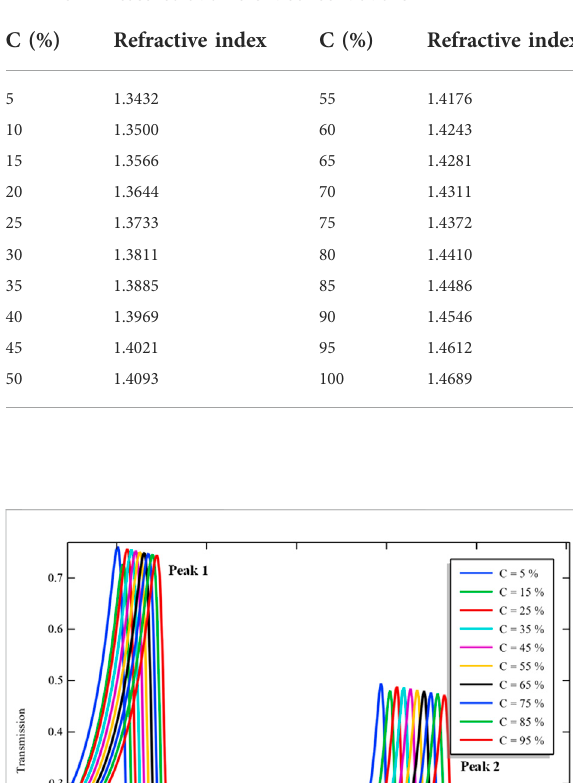
TABLE 5 RI measured at different concentrations.